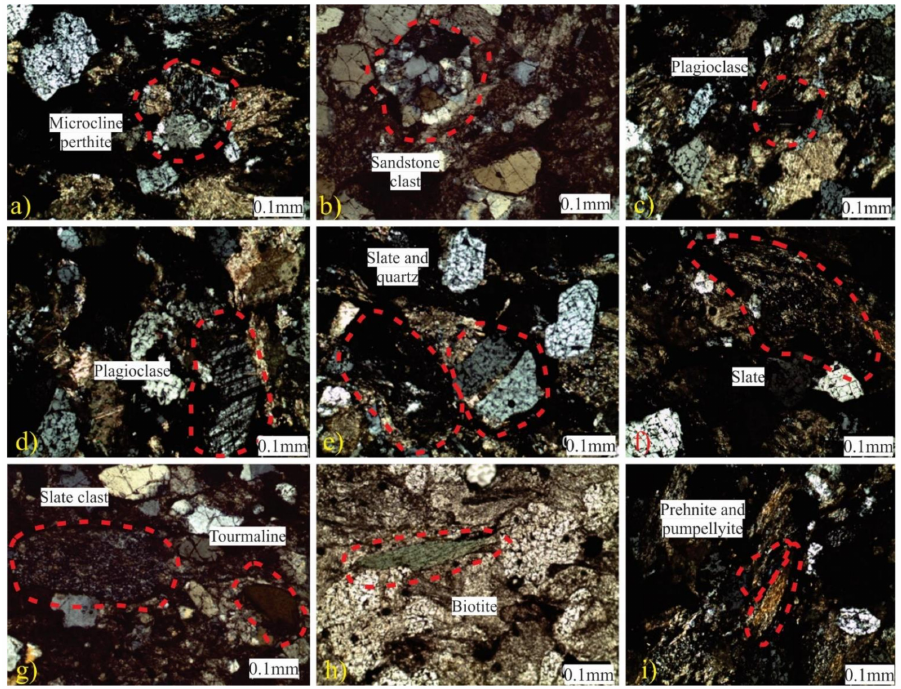
Figure 10. Photomicrograph displays ( a – c ) monocrystalline quartz in feldspathic litharinte, poly- crystalline quartz and plagioclase, ( d ) microcline perthite, ( e ) slate, ( f ) sandstone, prehnite and pumpellyite in feldspathic litharenite, ( g ) tourmaline in feldspathic litharenite, ( h ) biotite in felds- pathic litharenite and ( i ) prehnite and pumpellyite in feldspathic litharenite. Due to metamorphism, quartz grains have a stretched and strained quality, which is shown by the relatively small amount of monocrystalline quartz. Contact between quartz grains is observed to be planar and concavo-convex. In the feldspathic litharenite, alkali feldspar, and plagioclase are the predominant types of feldspar (Figure 10c). Alkali feldspar comprises microcline perthite (Figure 10d), while feldspathic litharenite consists of igneous, metamorphic, and sedimentary rocks as clast (such as slate and sandstone; Figure